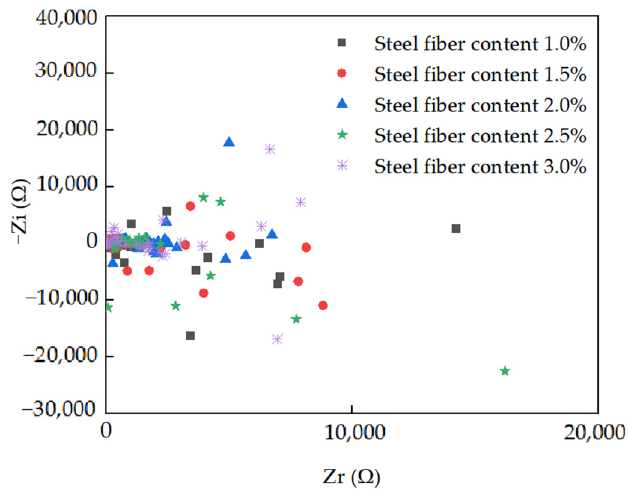
Figure 6. AC impedance spectrum curves.